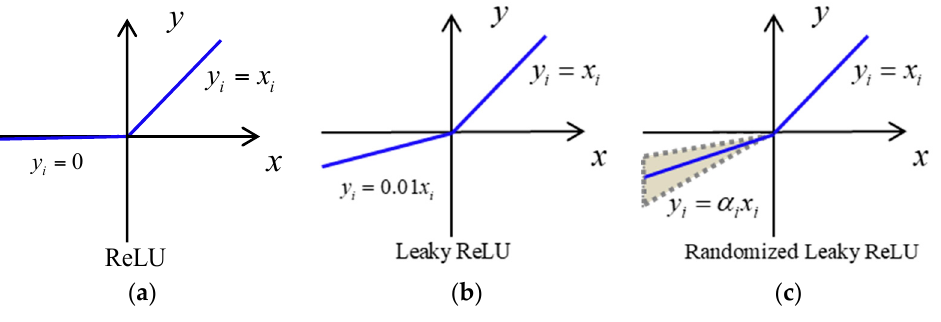
Figure 1. ReLU activation function and its variants. ( a ) ReLU function; ( b ) Leaky ReLU function; ( c ) Randomized Leaky ReLU function.